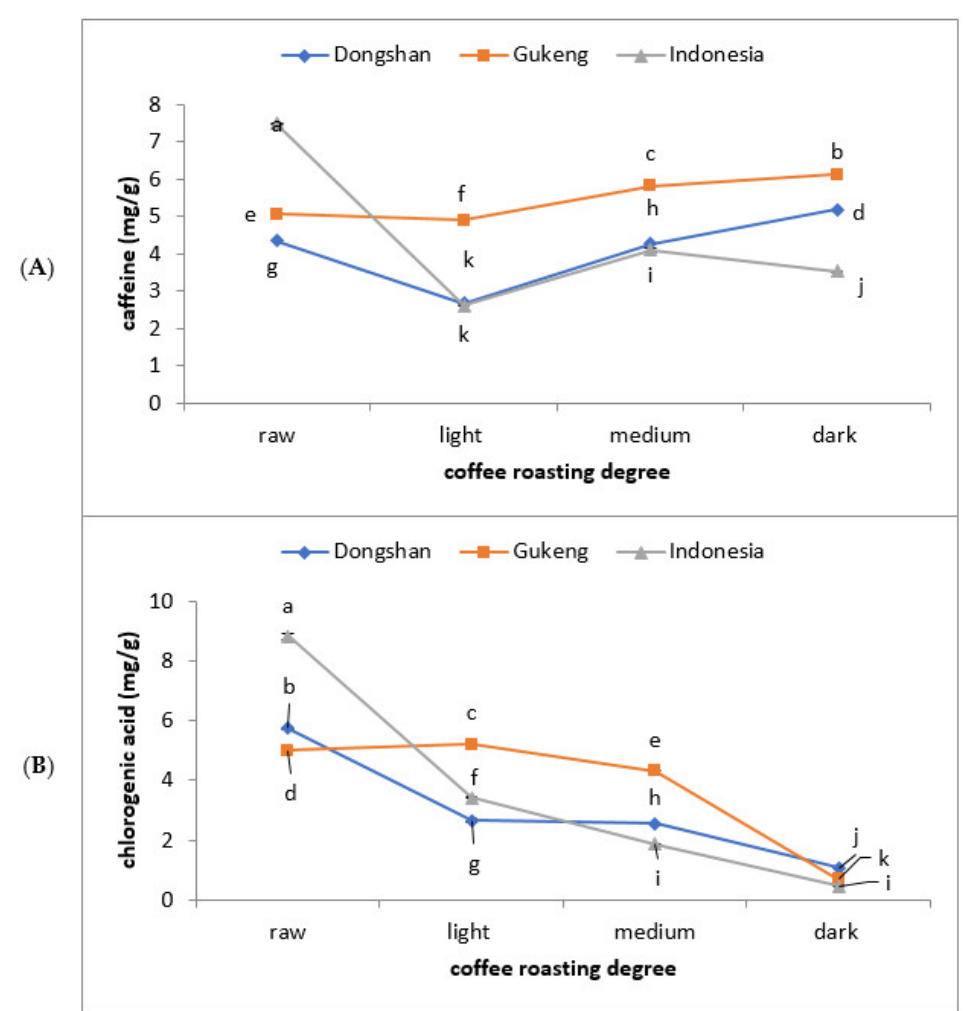
Figure 1. ( A ) Caffeine and ( B ) chlorogenic acid contents under different roasting degrees. Data are mean ± SD, n = 3. Mean statistical data within a column were obtained by Duncan’s test at the 5% level (same letters means no significant).